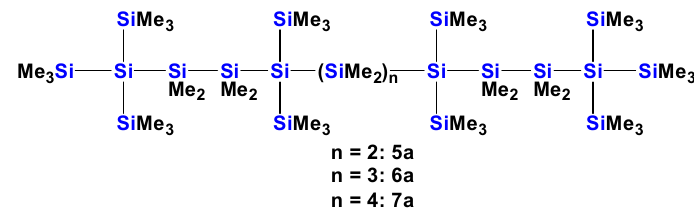
Figure 3. Compounds 5a , 6a , and 7a serve as reference standards for the judgement of the optical properties of the two series of oligosilanes 5 , 6 , and 7 as well as 11 , 12 , and 13